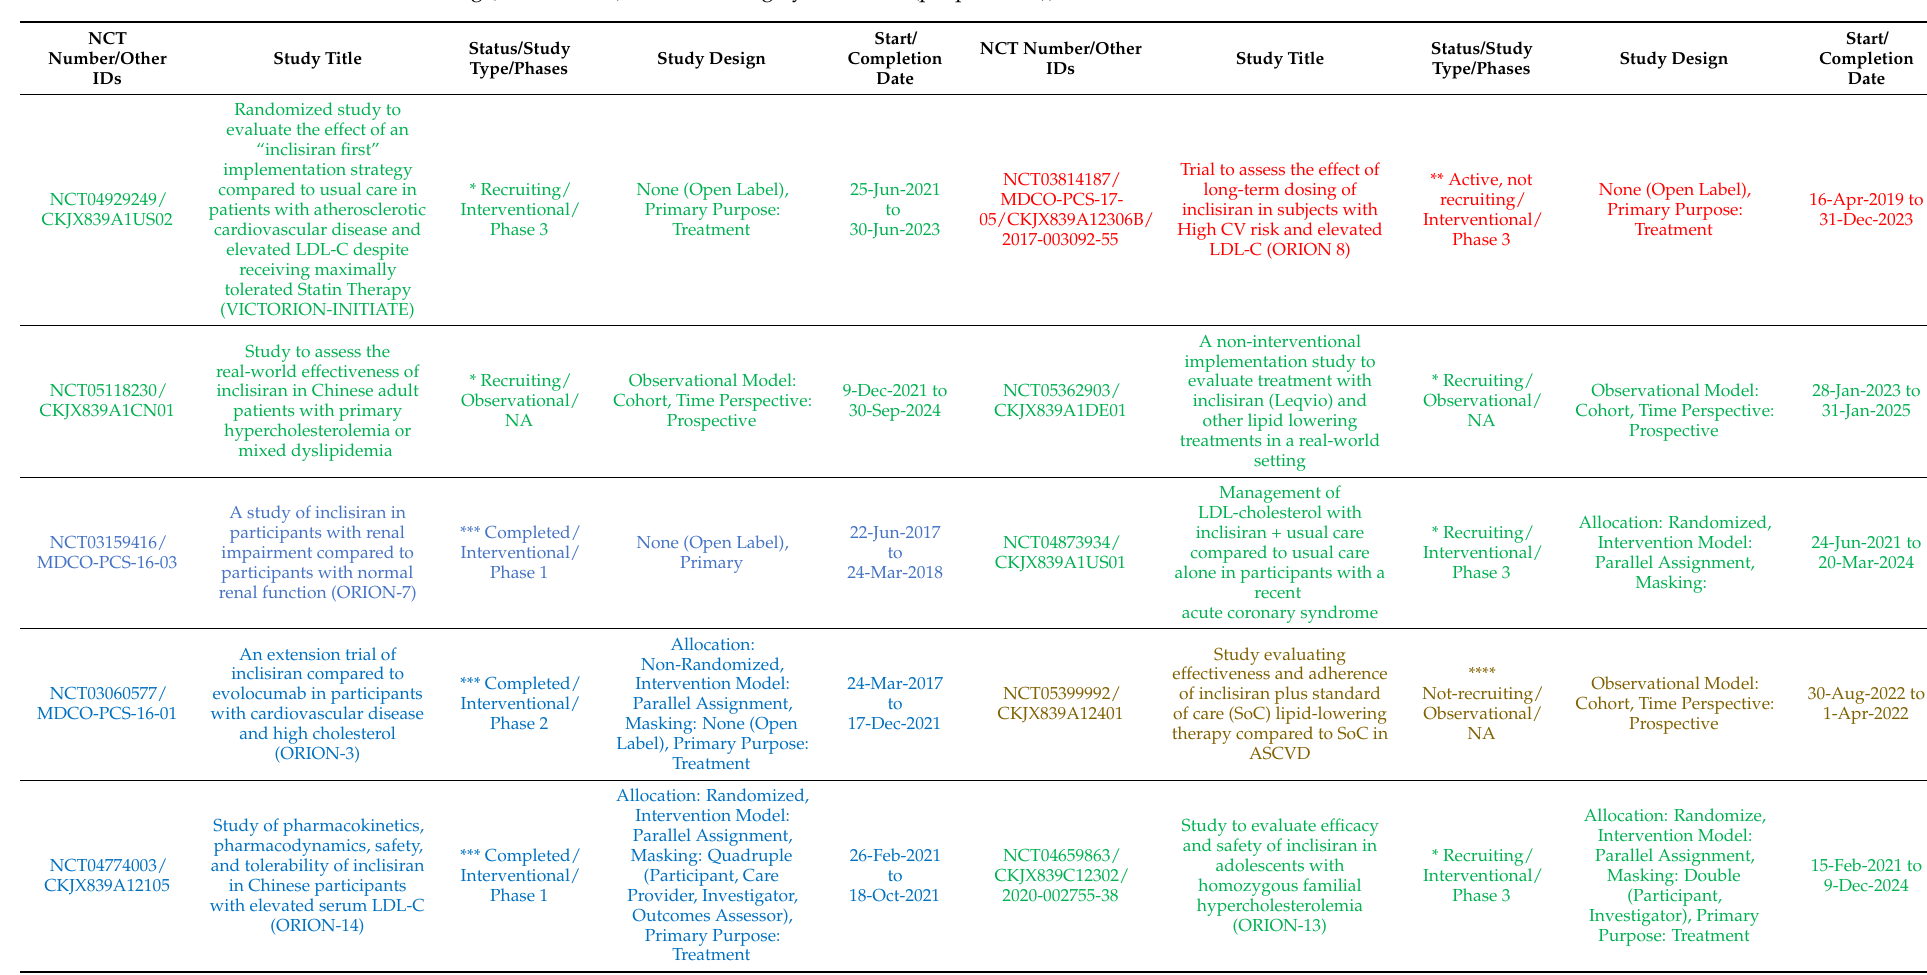
Table 3. The current registered clinical studies on inclisiran [169] (* recruiting (green color), ** active, not recruiting (red color), *** completed (blue color), **** not-recruiting (brown color), ***** enrolling by invitation (purple